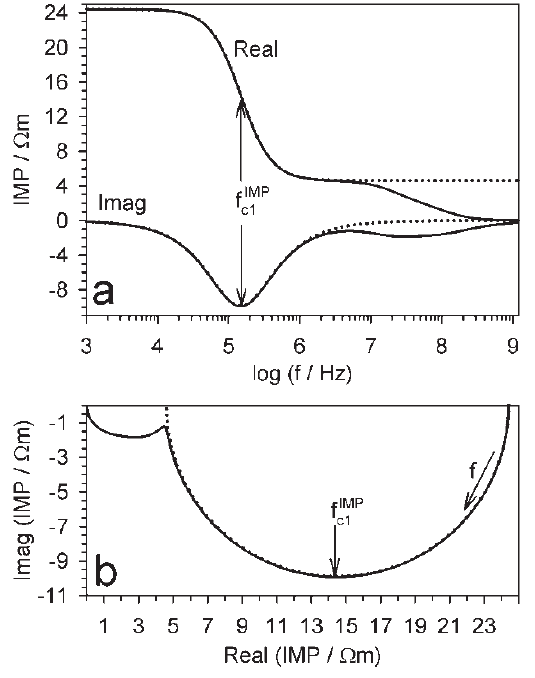
Fig. 10: Real and imaginary parts of the specific impedance * ) of a cell suspension over frequency (top), as well (IMP= 1/ σ S as in the complex plane (bottom) calculated for the parameters of Table 1 (full lines, equation (18)). The spectra are reduced to the membrane dispersion when the permittivities of the bulk media are neglected (dotted lines, equation (19)). The characteristic membrane-dispersion frequency of the suspension f corresponds to the frequency of the peak in the imaginary part. In the complex plot, it is the frequency of the point obtained by dropping a perpendicular from the center of the semicircle.